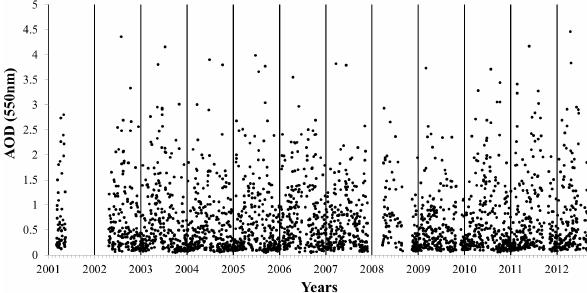
Figure 2. Daily AOD at 550nm wavelength from AERONET in Beijing from 2001 to